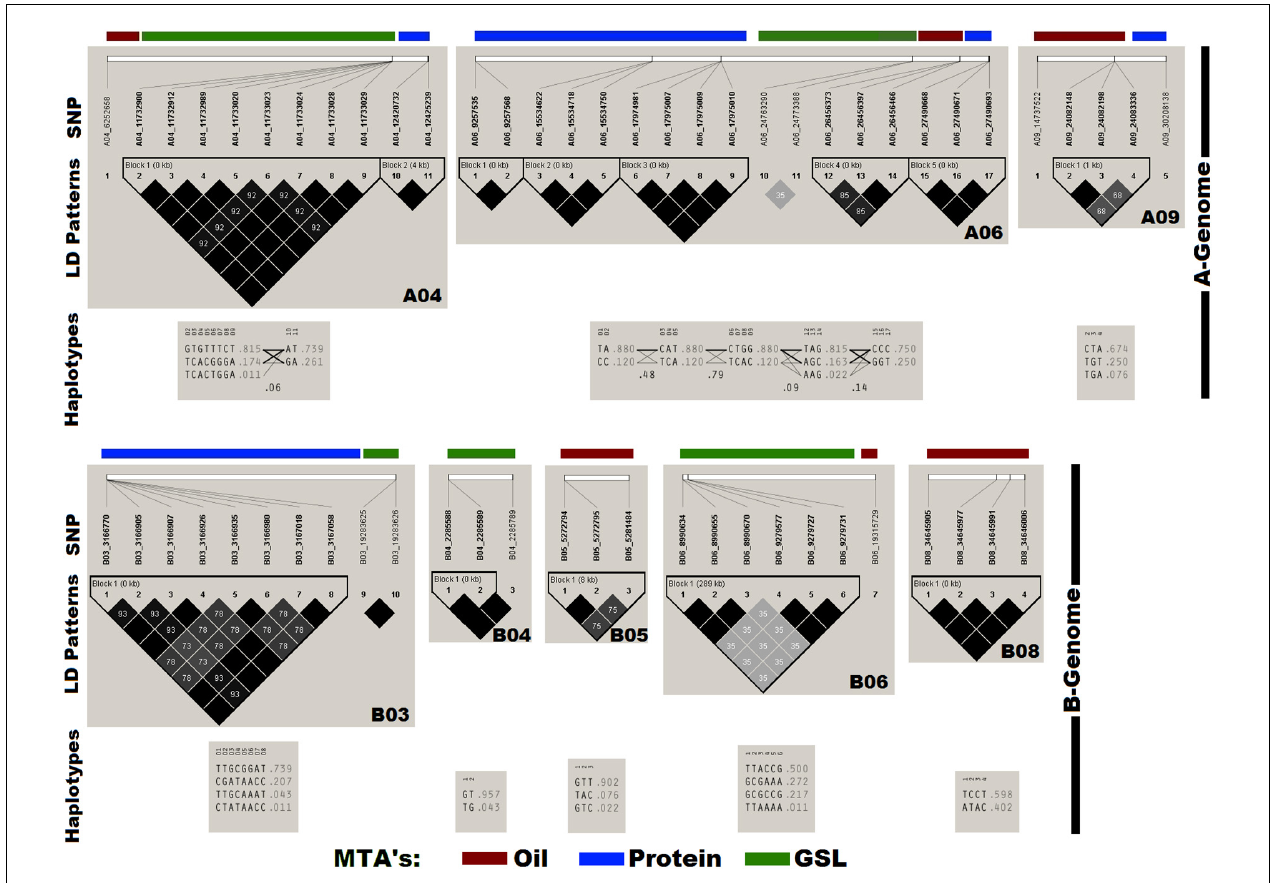
FIGURE 3 | Chromosome-wise linkage disequilibrium (LD) plot generated using Haploview. The plot also depicts the haplotypes block containing the annotated SNPs for OIL, PTN, and GSL. Dark gray colors in LD plots indicate strong LD between markers as estimated by r 2 values.